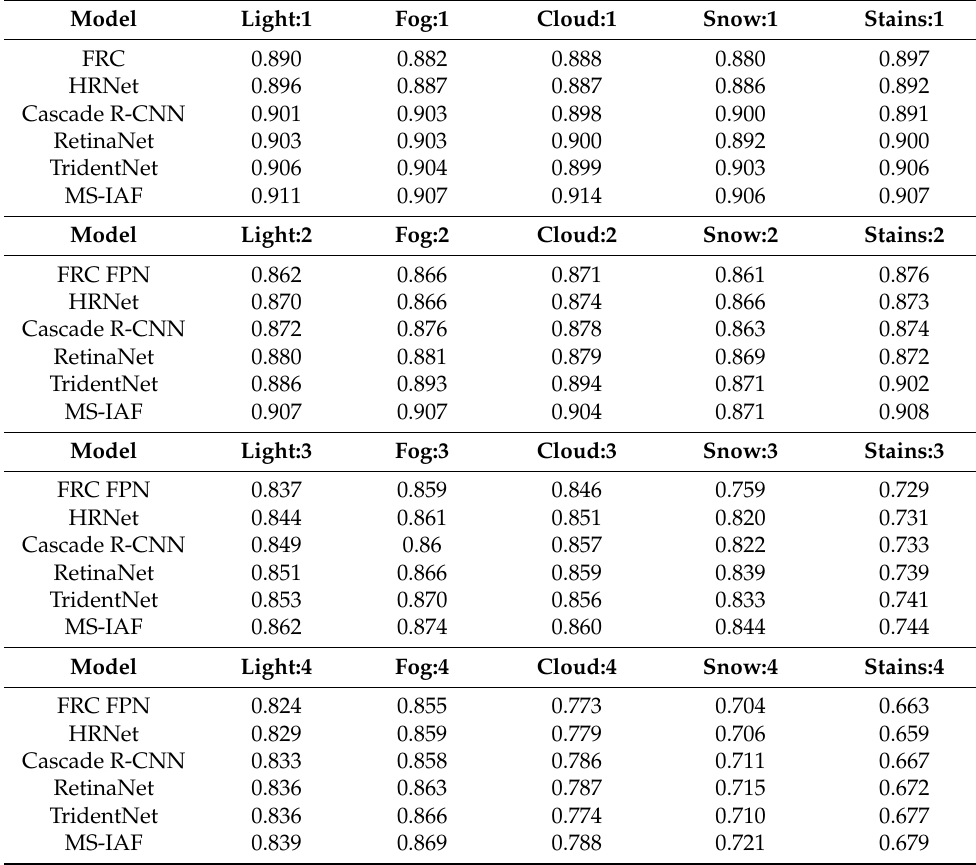
Figure 10. Pollutions with different levels of severity (Imgaug for image processing). Table 3. Test AP results of pollutions with different levels of severity.